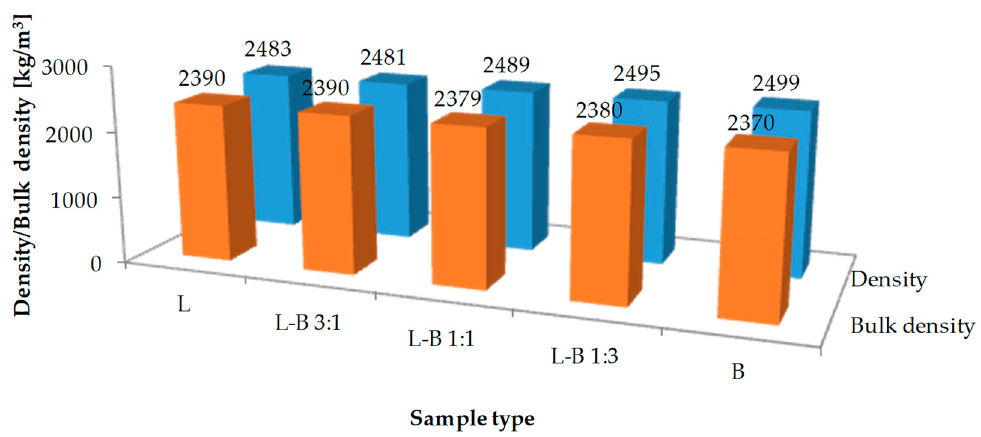
Materials 2019 , 11 , x Figure 6. Maximum density and bulk density results of the studied mixes.